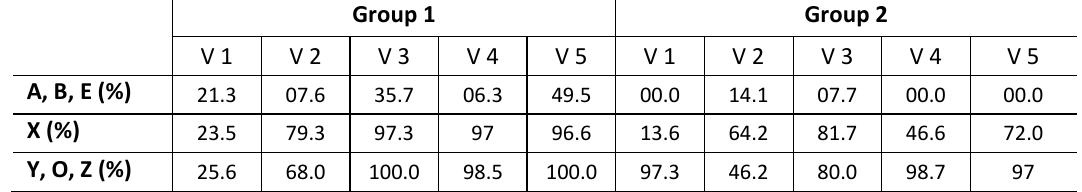
Table 5. Percentage of missing points of each characteristic point in each volunteer for both